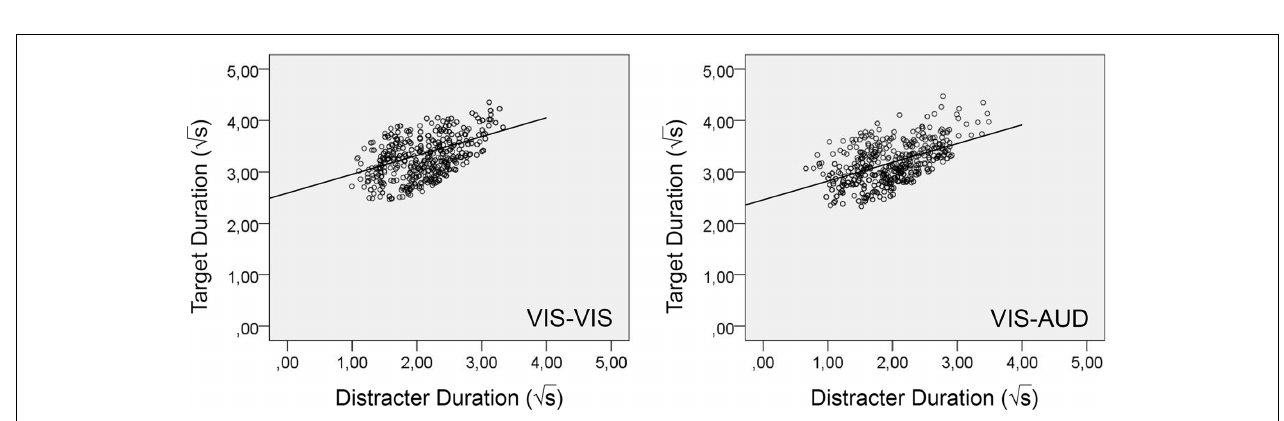
FIGURE 2 | Histograms for times produced in Experiment 1. Upper panel: Frequency distributions for the target durations. Lower panel: Frequency distributions for the distracter durations. Each distribution is accompanied